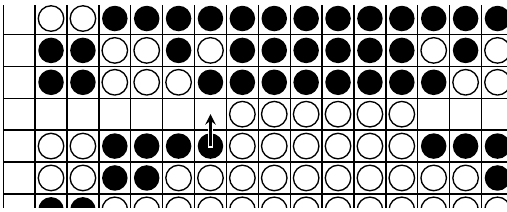
Figure 88. The lower BLACK